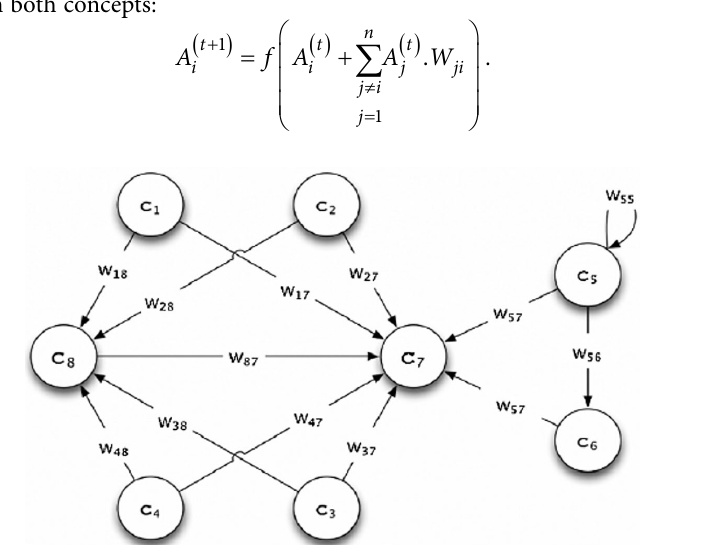
Fig. 1. Typical structure of an FCM Source: Salmeron (2012: